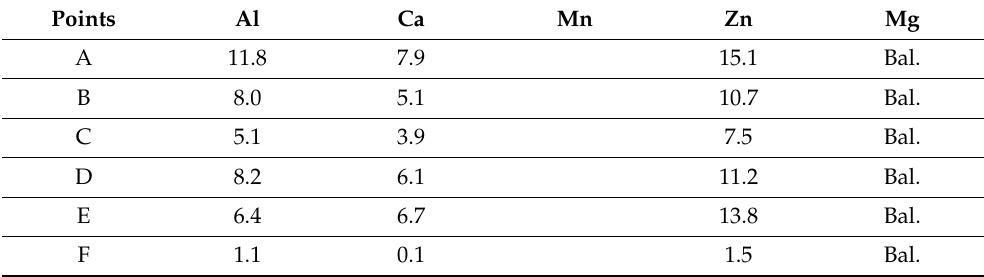
Figure 3. SEM image of homogenized ZAXM4100 alloy sheets. Table 1. Chemical composition (in at.%) of the matrix and particles in homogenized ZAXM4100 alloy sheets indicated by yellow arrows inserted in Figure